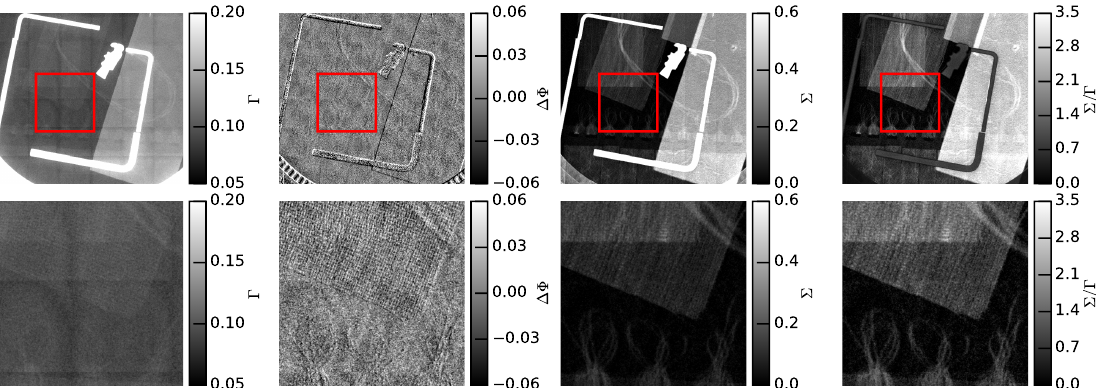
Figure 5. From left to right: Attenuation, differential phase, dark-field image and normalised scatter image of the test samples from Figure 3, taken at 60kVp and 7.5mAs per phase-step. The region marked by a red square is shown in detail in the bottom